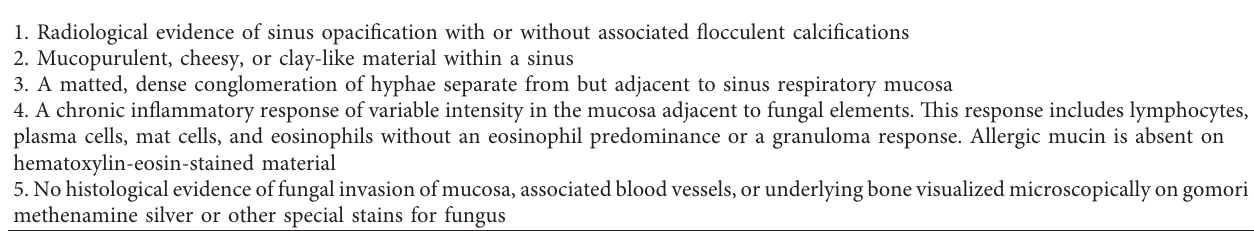
Table 2: DeShazo et al.’s [7] diagnostic criteria of fungus